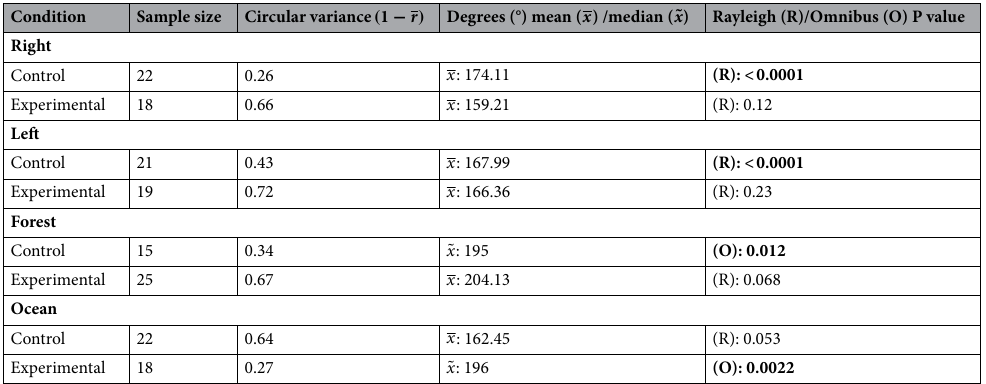
Table 2. Movement patterns of handled crabs exposed to control vs experimental stimuli. Results include: Circular variance, a measure of circular spread of the data points; mean/median bearing direction reported in degrees (°) across all individuals; Rayleigh test for significance of mean direction (R), or omnibus test for significance of median direction (O); Data separated by stimulus direction (Right = 117°, Left = 297°, Forest = 27°, Ocean = 207°). Significant values are in